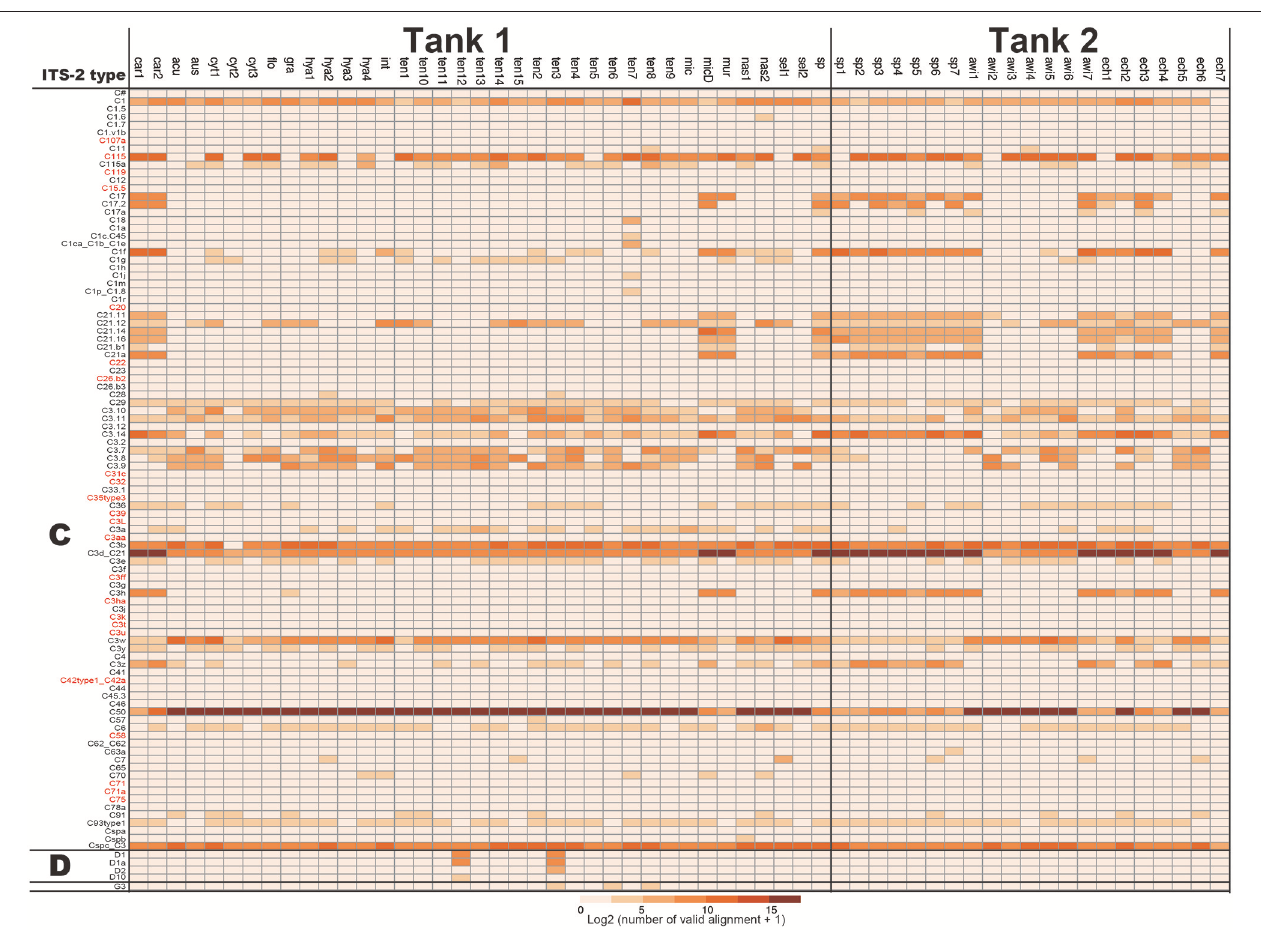
FIGURE 2 | Numbers of ITS-2 types detected by PCR using r18Sf and Sym28Sr primers for identifying symbiotic Symbiodinium types in each Acropora colony. ITS-2 types that share the same GeoSymbio names in the database were summed (raw numbers of valid alignments are available in Supplementary Material). Numbers of valid alignment were shown at log2 scale and colored. ITS-2 types belonging to the same clade (C or D) are separated. ITS-2 types in red were not detected from eDNA (see Figure 4